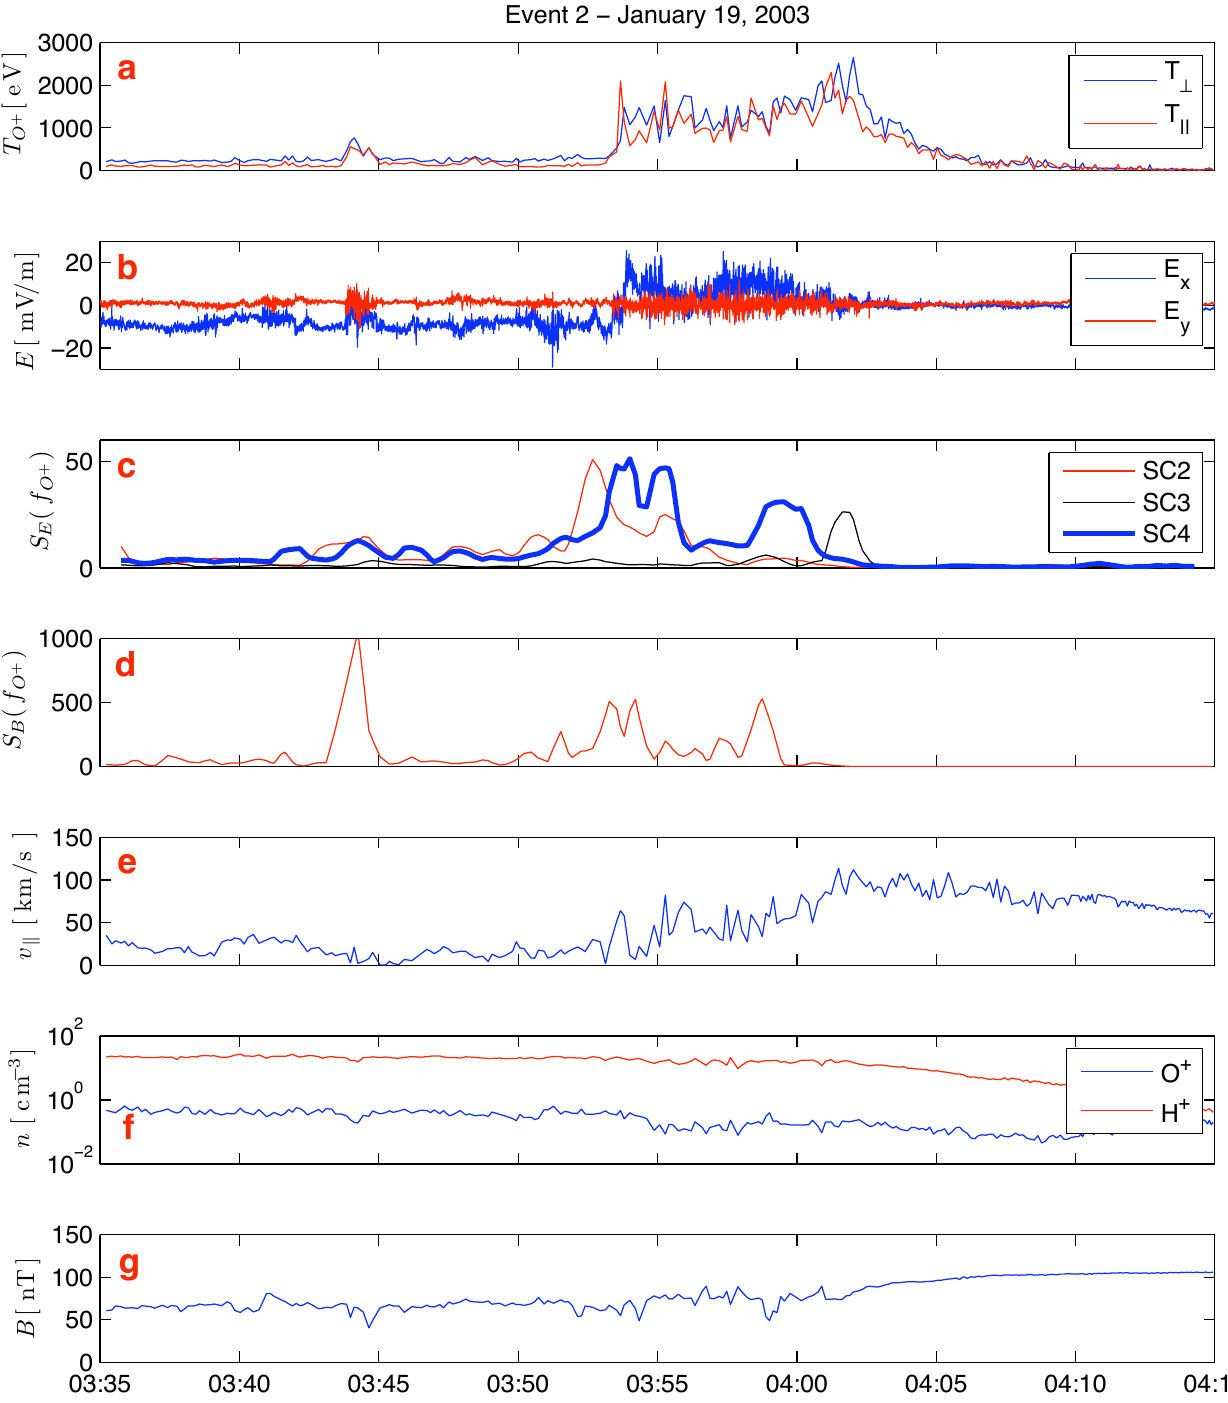
Fig. 5. SC4 measurements for Event 2 (19 January 2003): Panel (a) shows the perpendicular (blue) and the parallel (red) O + temperatures, panel (b) the electric field for the two components measured in the satellite spin plane, panel (c) the power spectral density at f O + for the electric field given in (mVm − 1 ) 2 Hz − 1 measured by different spacecraft (the blue line corresponds to SC4), panel (d) the power spectral density at f O + for the magnetic field given in (nT) 2 Hz − 1 , panel (e) the O + parallel velocity, where the outflow direction is defined to be positive, panel (f) the number densities for O + (blue) and H + (red), and panel (g) the magnitude of the background magnetic